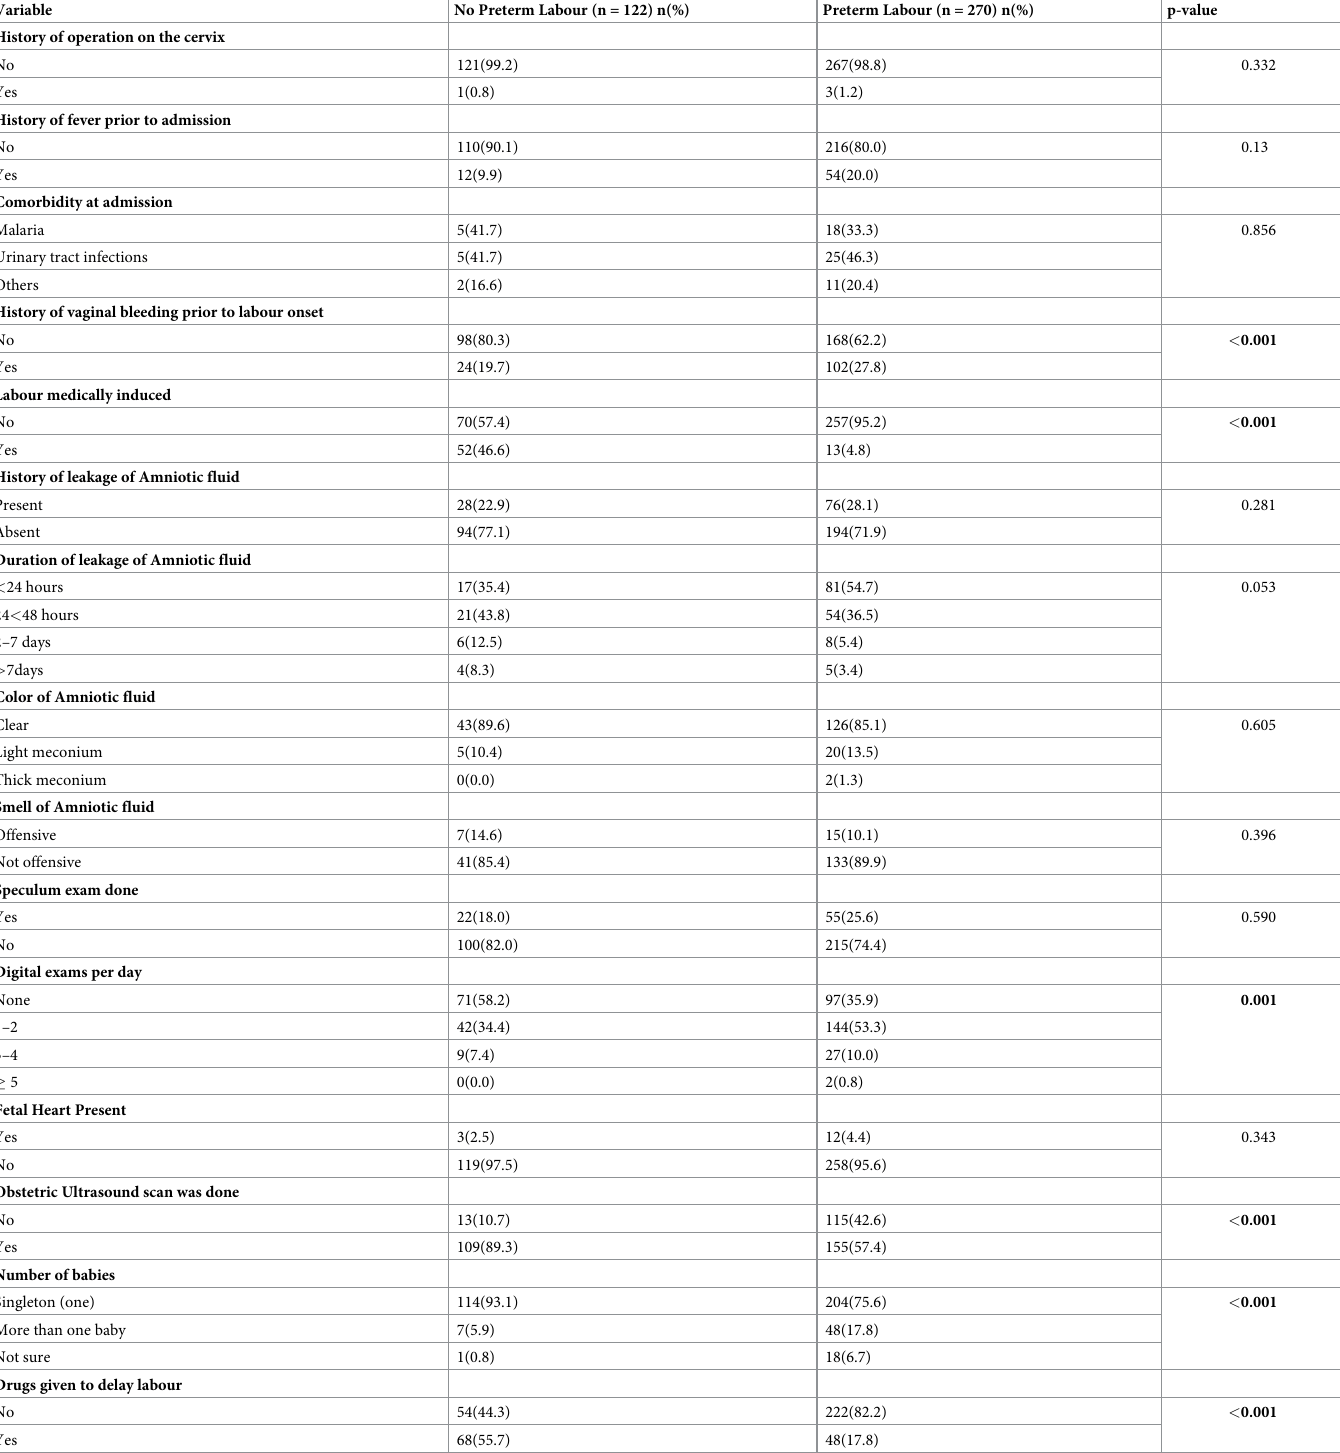
Table 2. Baseline and obstetric characteristics of 392 women admitted between 24 to 28 weeks of gestation at Kawempe National Referral Hospital, Kampala, Uganda.